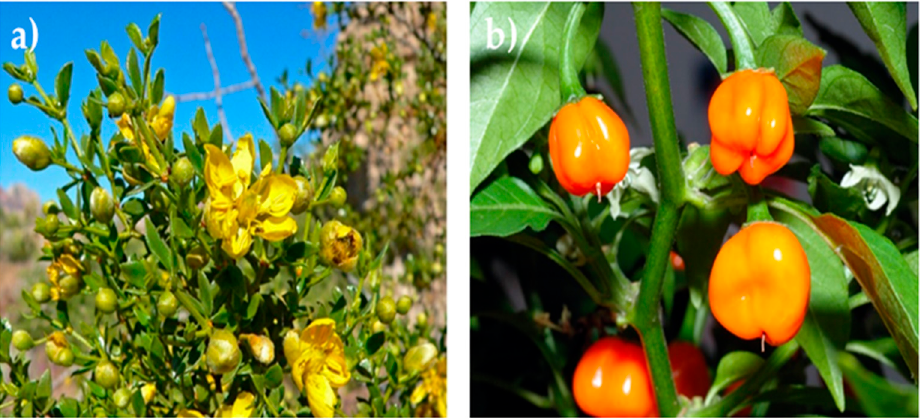
Figure 3. Plants of ( a ) Larrea Tridentata (gobernadora) and ( b ) Capsicum Chinense (habanero).